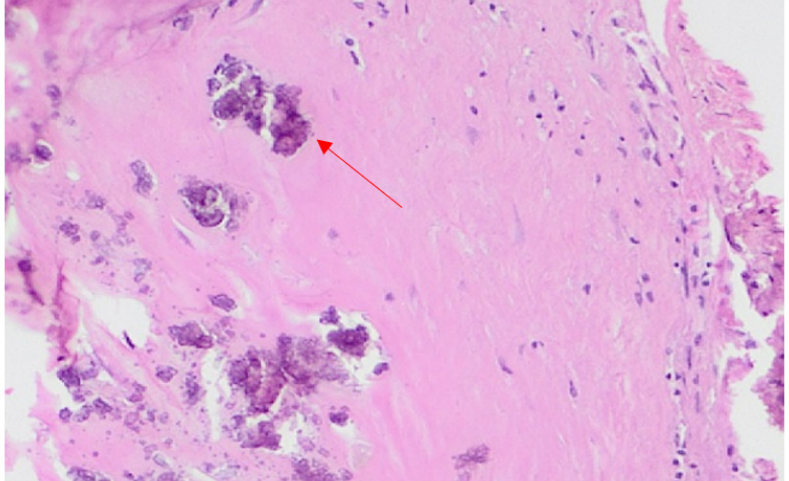
Figure 3. Details of the fibrous capsule characterized by early stage of granulation tissue-type stroma, re-active gliosis, and calcium deposition (red arrow) (H–E ×10).